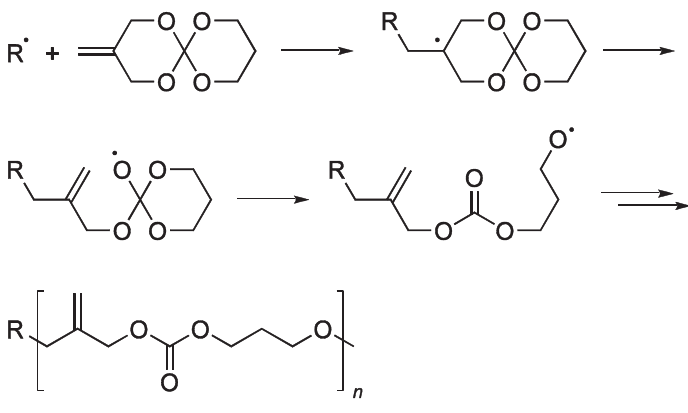
Figure 8. The radical ROP of a spiro carbonate.